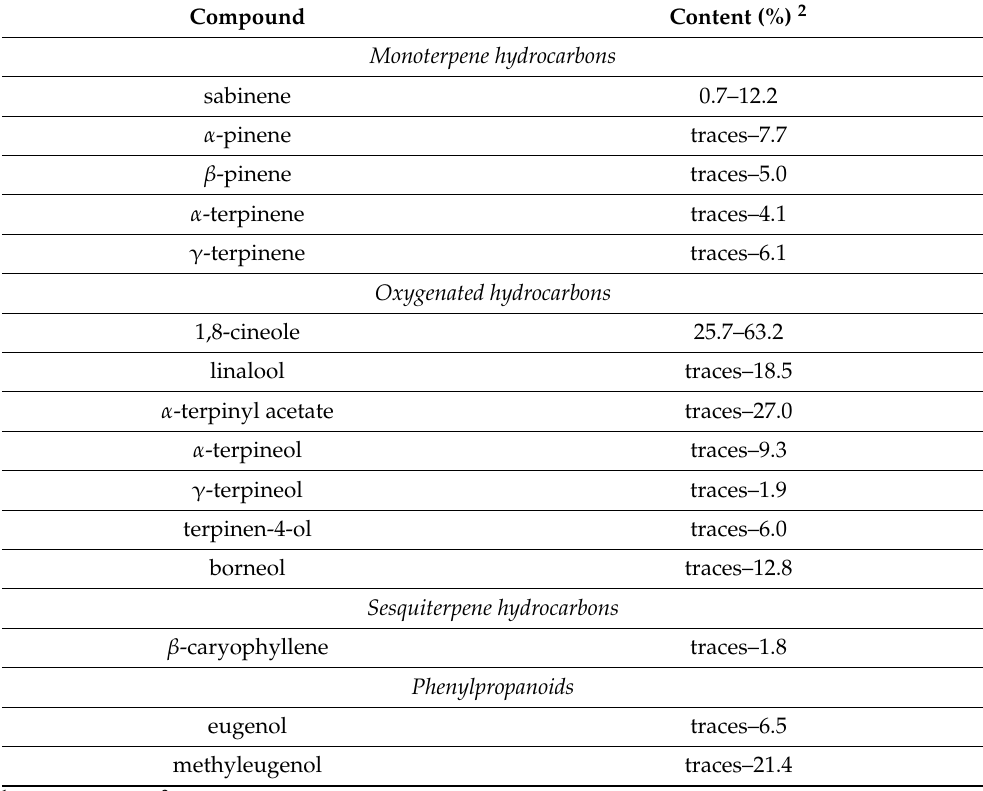
Table 2. Summary of the percent content variation of the main volatiles of bay laurel leaf EO irrespective origin 1